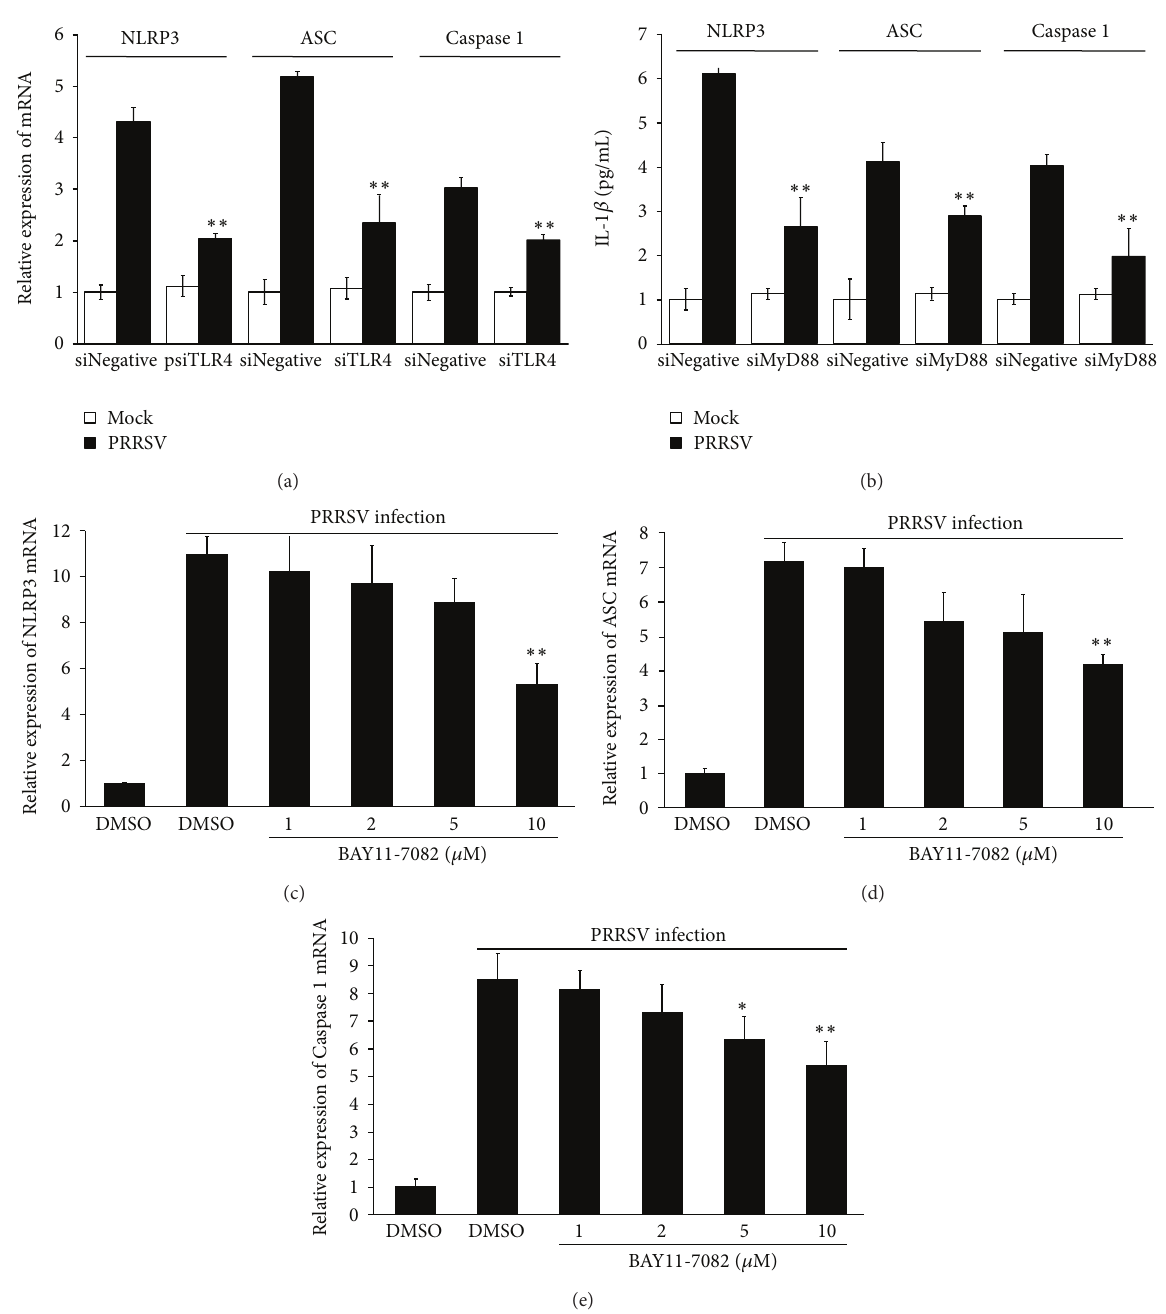
Figure 8: TLR4/MyD88/NF- 𝜅 B signaling pathway is involved in PRRSV-induced expression of NLRP3 inflammasome components. (a, b) PAMs were transfected with 80 nM of psiNegative, psiTLR4, or psiMyD88, respectively. At 24 h posttransfection, cells were mock infected or infected with PRRSV at a MOI of 0.1. The cells and supernatants were harvested separately 36h later and analyzed by NLRP3/ASC/caspase 1 specific real-time RT-PCR. (c–e) PAMs were mock infected or infected with PRSSV at a MOI of 0.1, followed by treatment with NF- 𝜅 B inhibitor (1, 2, 5, and 10 𝜇 M) or DMSO vehicle in the absence of serum, for 36 h. The cells were then harvested to analyse the mRNA expression of NLRP3 (c), ASC (d), and caspase 1 (e), respectively, by real-time RT-PCR. ∗ 𝑃 < 0.05 and ∗∗ 𝑃 < 0.01 compared with DMSO-treated cells plus PRRSV